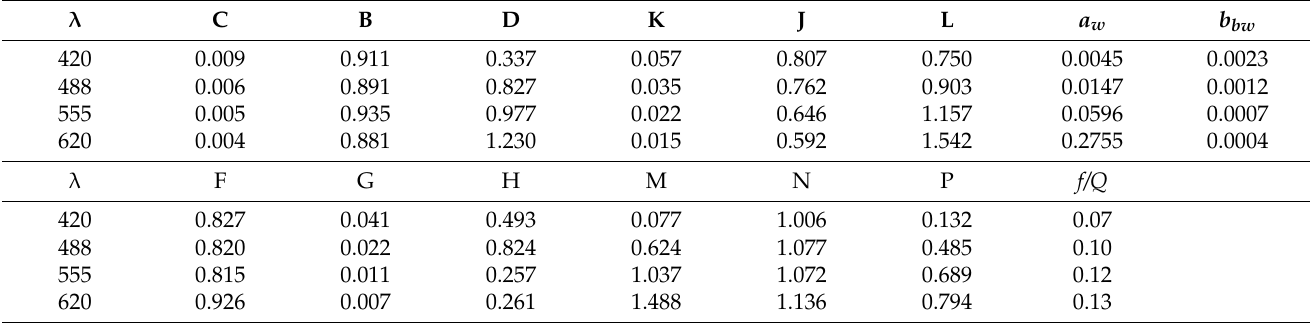
Table 3. The constants of the five-parameter model of R rs ( λ i ) (Equations (43)–(46)).